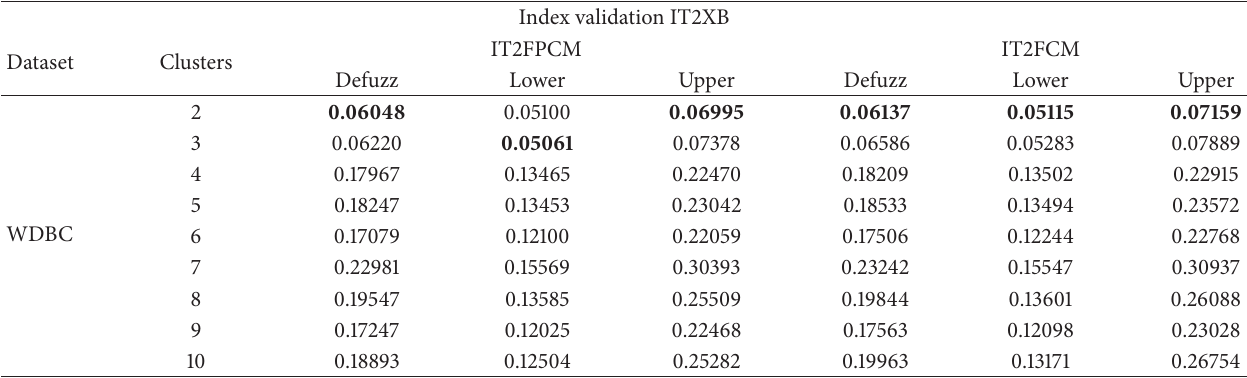
Table 3: Results of the IT2XB validation index for WDBC dataset clustering using IT2FPCM and IT2FCM algorithm with 𝑚 = [1.5, 2] and 𝜂 = [1.5, 2.5] as